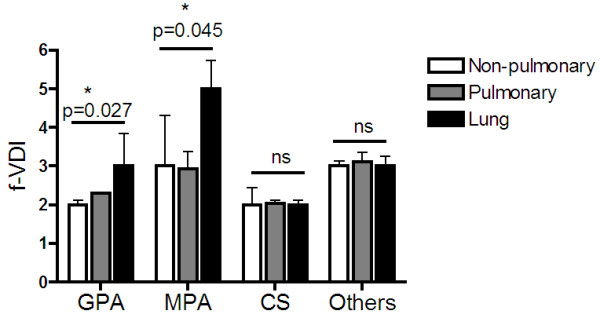
VDI scores at 2-year follow-up (f-VDI) in subjects presenting initially with lung, pulmonary and non-pulmonary manifestations diagnosed with different AAV phenotype. Data are represented as mean ± SEM. A three-way ANOVA test was used to calculate differences between the groups with a significance p-value cut-off of 0.05 (*p < 0.05, **p < 0.01, ***p < 0.001).